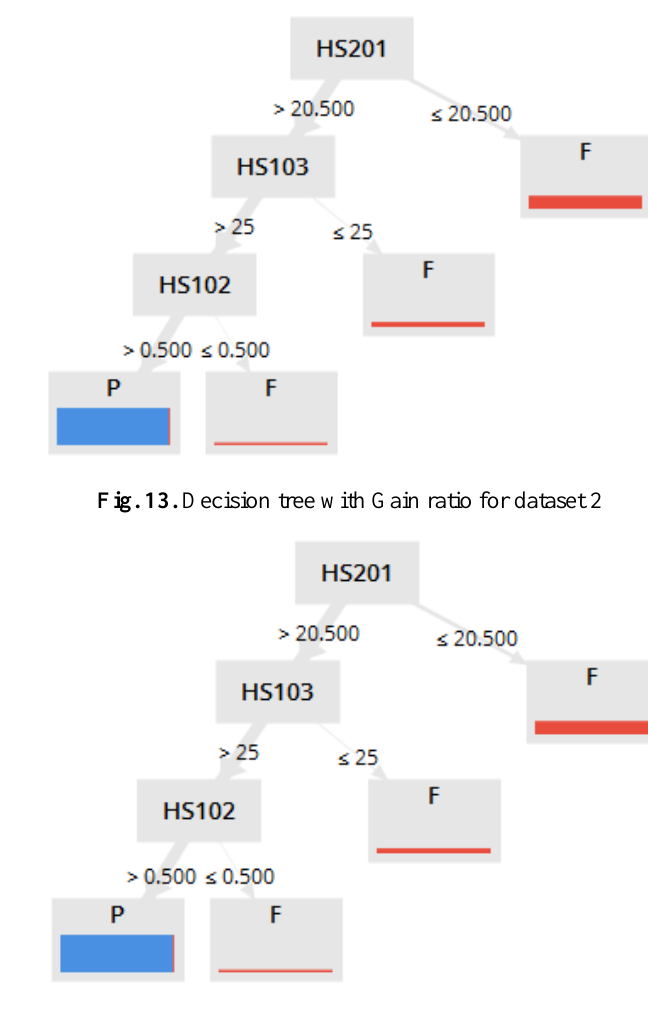
Fig. 14. Decision tree with Gini index for dataset